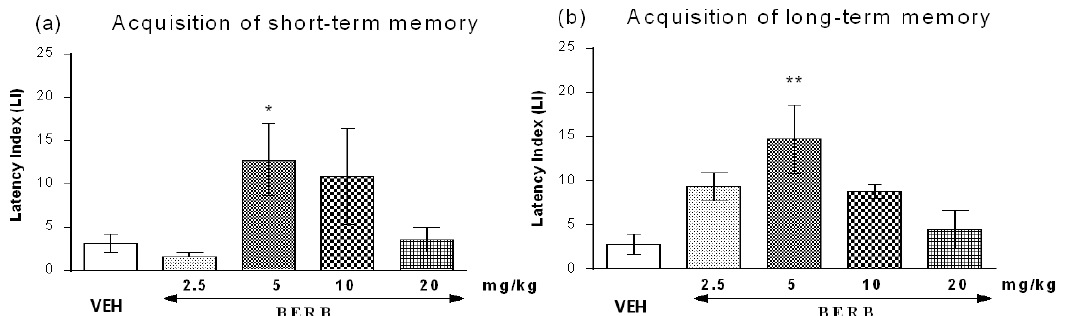
Figure 5. Effects of an acute berberine (BERB) on the latency index (LI) during the short-term or long-term acquisition trials using the PA test in mice. BERB (2.5, 5, 10 and 20 mg/kg; i.p.) or vehicle (VEH) were administered: 30 min before the first trial and animals were re-tested 2 h (for short-term memory ( a )) or 24 h (for long-term memory ( b )) later; n = 10–11; the means ± SEM; * p < 0.05; ** p < 0.01 vs. VEH-treated control group; Tukey’s test.